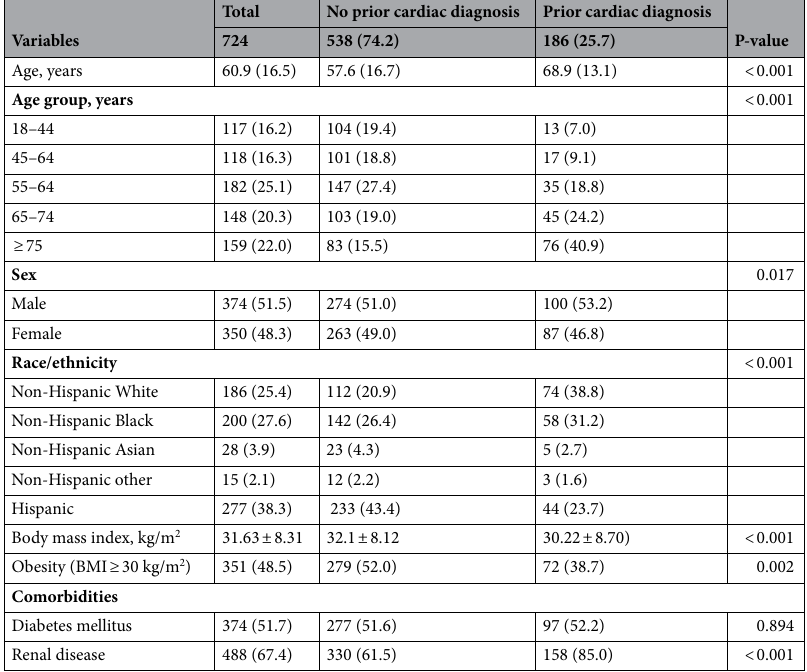
Table 1. Baseline characteristics of the sample of adults hospitalized for COVID-19 stratified by prior cardiac diagnosis. Mean ± standard deviation and number (column%)